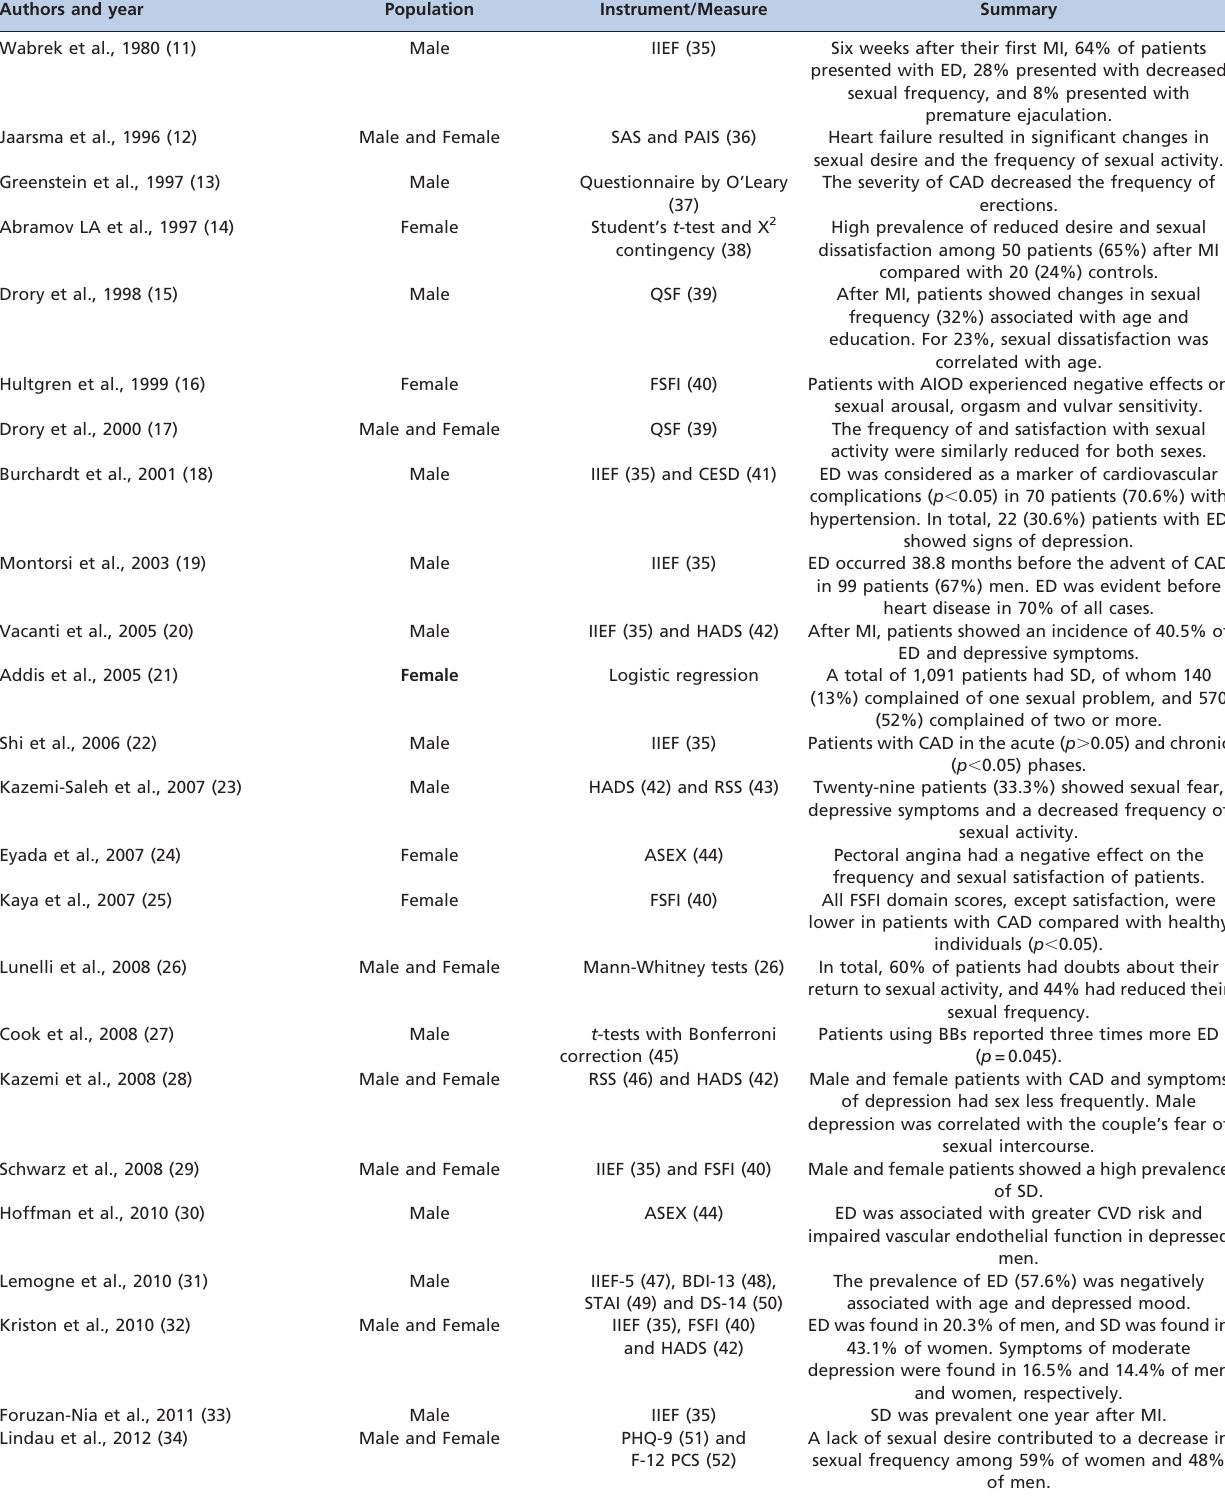
Table 1 - Published studies regarding the prevalence of sexual dysfunction in patients with cardiovascular